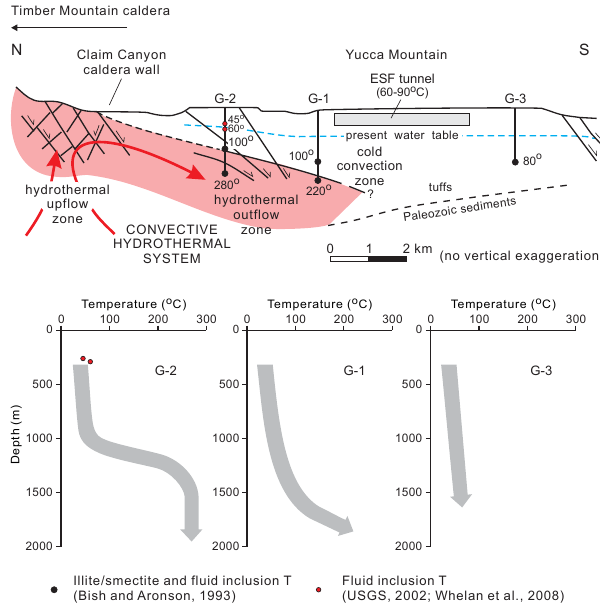
Figure 1. Reconstruction of the Timber Mountain hydrothermal cir- culation system near Yucca Mountain 10.0–11.5Ma (upper figure) and schematic temperature profiles for boreholes USW G-1, G-2 and G-3 estimated from illite/smectite mineralogy and fluid inclu- sion data (lower figure). Modified from Bish and Aronson (1993). The box in the upper figure shows the approximate location of the ESF tunnel complex, from which elevated fluid inclusion tempera- tures were